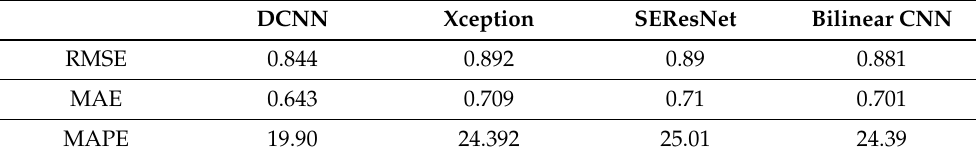
Table 7. Model prediction result